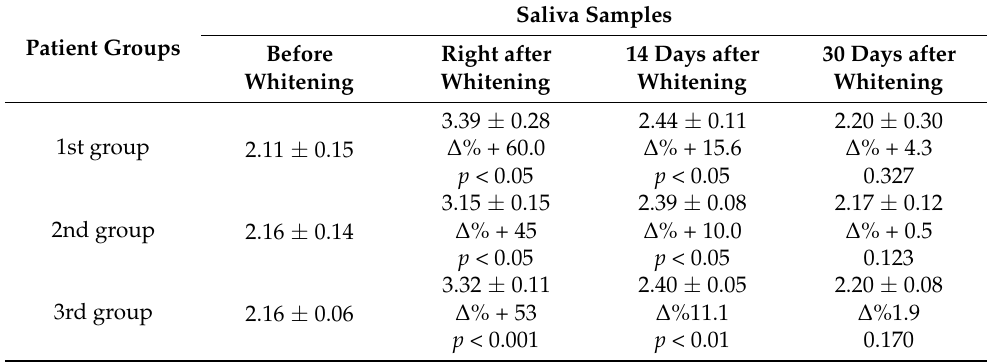
Table 1. Concentrations of calcium in the oral fluid before and at different times after tooth whitening (mM).